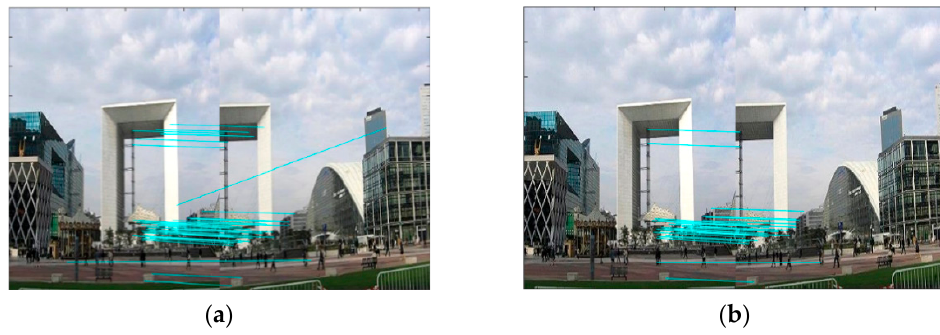
Figure 8. The registered images for T2: ( a ) I-RANSAC; ( b ) IIR. In complex scenarios, I-RANSAC mismatches, as shown in T2( a ), and IIR eliminates mismatches, as shown in T2( b ). Table 2. A comparison of feature point information between two algorithms.